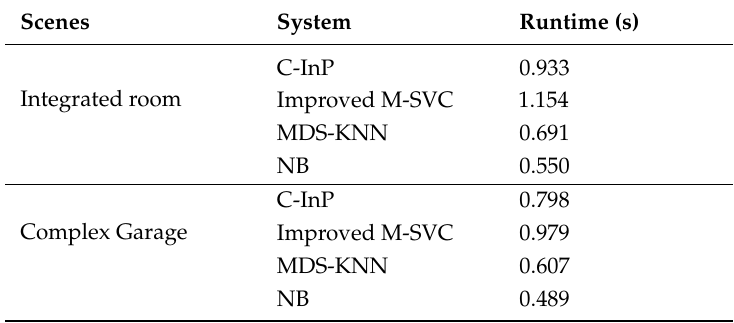
Table 3. Computational complexity of different positioning